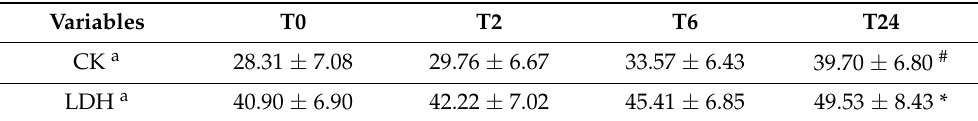
Table 2. Plasma creatine kinase and lactate dehydrogenase levels. Variables